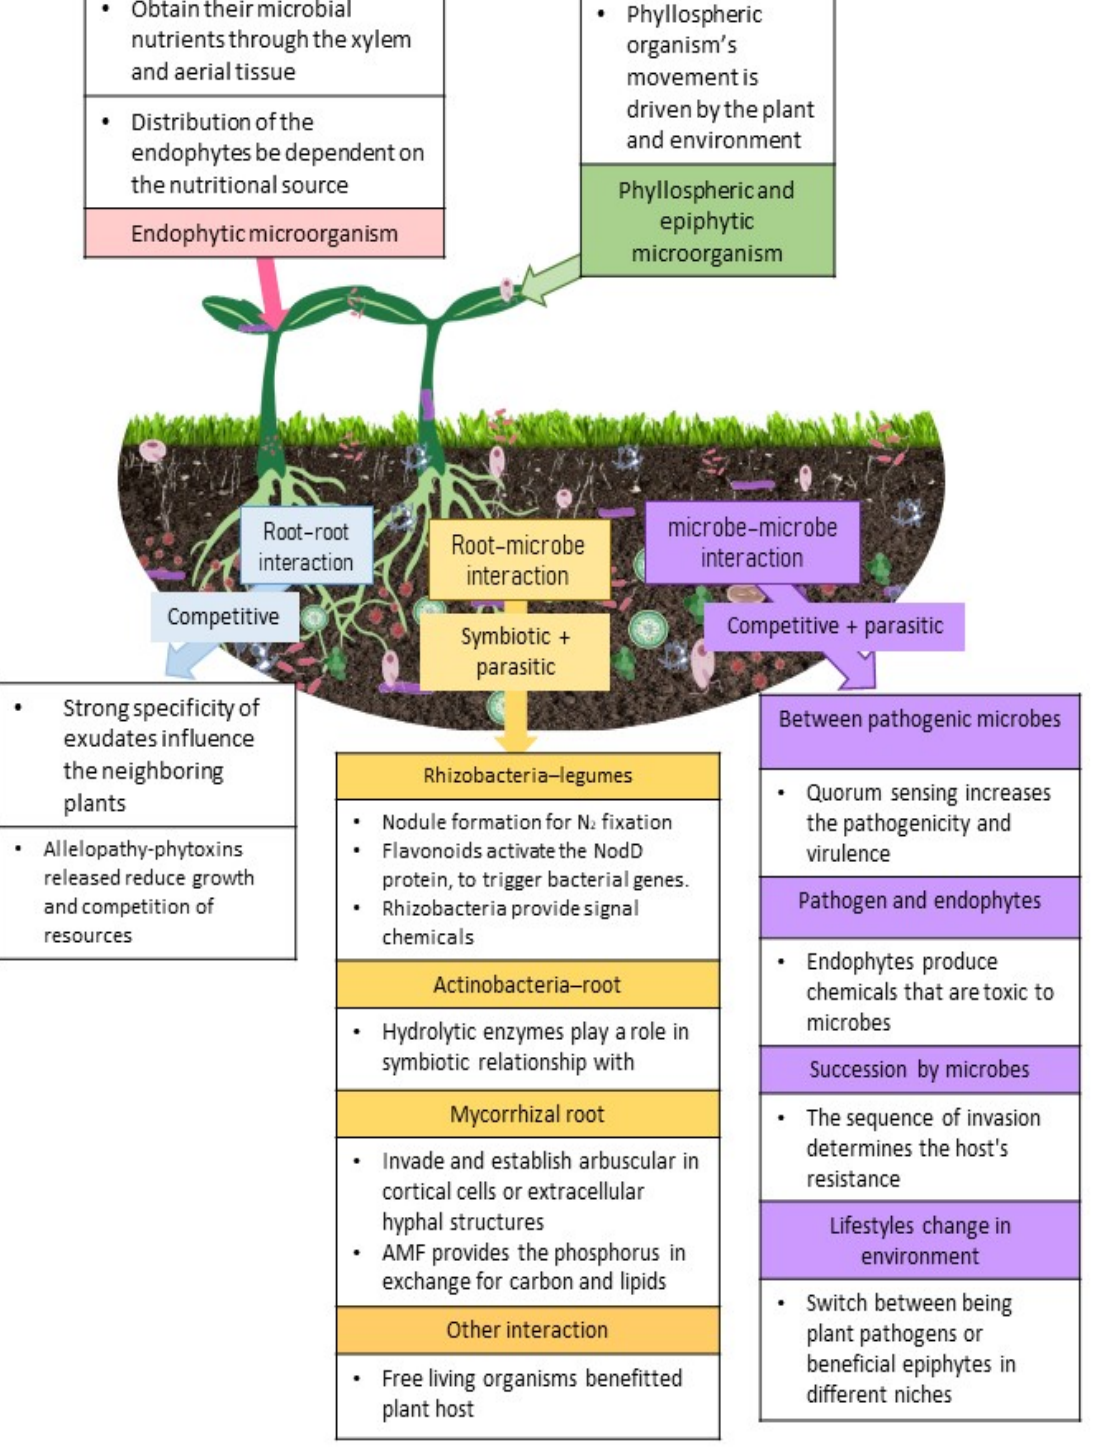
Figure 1. Shows the plant-microbe interactions aboveground and belowground observed in a plant’s natural environment. The pink box covers endophytic microorganisms, whereas the green box describes phyllosphere and epiphytic microorganisms. The purple column provides the explanation for microbe–microbe interaction; the orange column shows the explanation for root–microbe contact, and the blue column for root–root interaction. 3. Microbes and plant immunity.